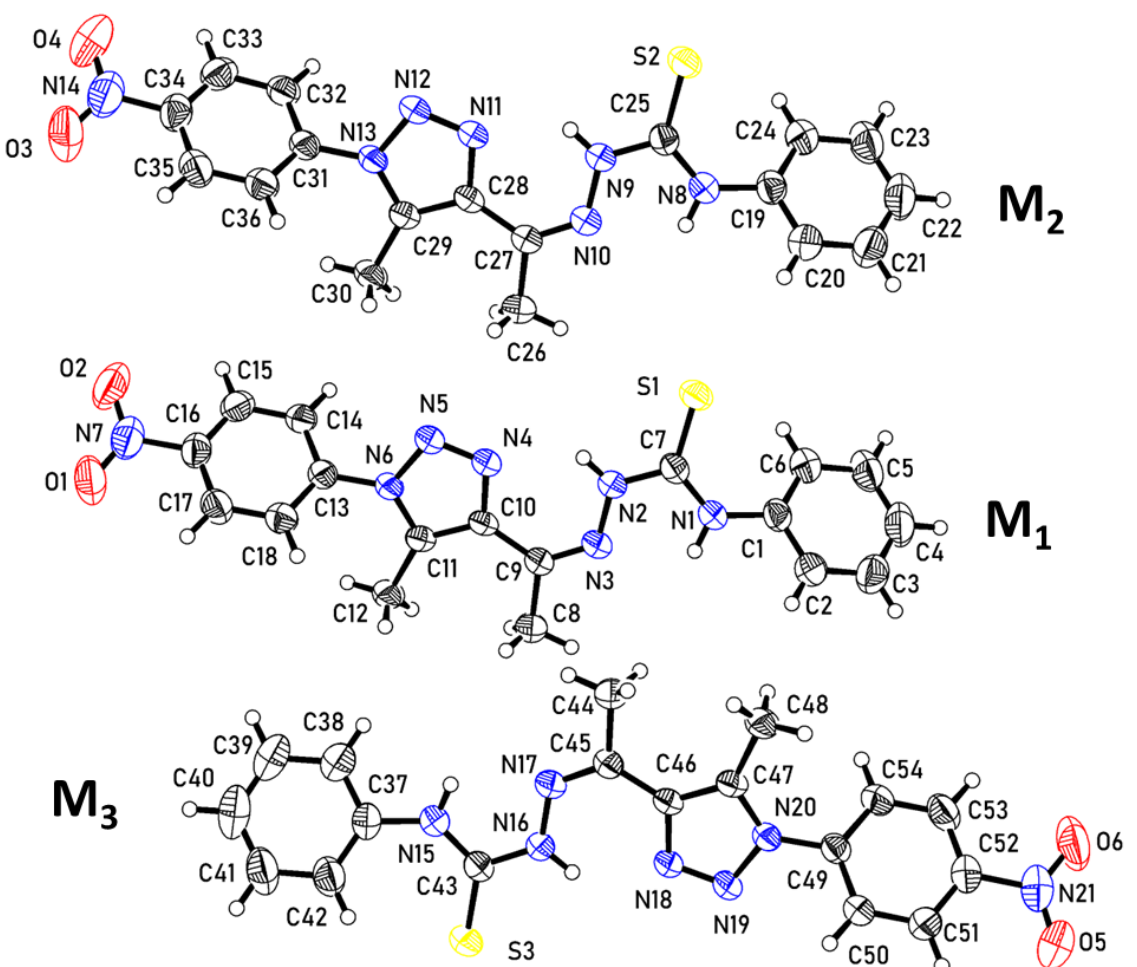
Figure 1. An ortep representation of the three unique molecules in the crystal structure of 3 showing 50% probability atomic displacement ellipsoids.